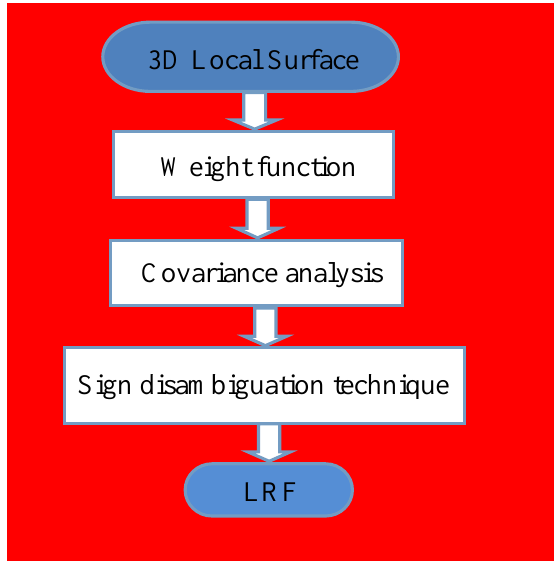
Figure 1. The process diagram of building a local reference frame.